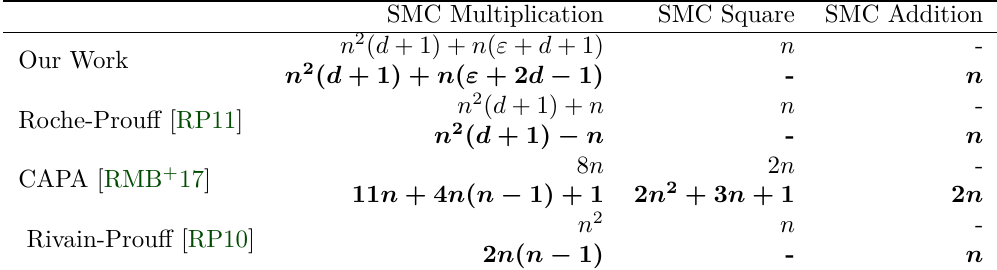
Table 4: Performance Comparison of Secure Operations in terms o ffield operations; field additions are shown in normal font while the number Field Multiplications are in bold font. SMC Multiplication SMC